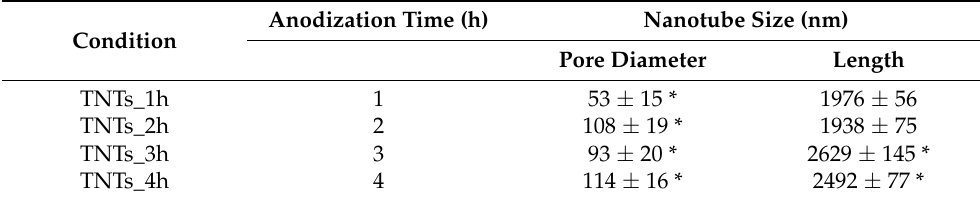
Figure 3. The FESEM micrographs showing the top and side morphological views of the titanium oxide nanotubes fabricated at 1 h ( a , e ), 2 h ( b , f ), 3 h ( c , g ) and 4 h ( d , h ). The morphology images depict the TNTs orientation and the size of the pores. The pores diameter of the nanotube increased with increase in the anodization time while the length decreased. Table 1. Shows the measured inner pore diameters and length of the TNTs at 1, 2, 3 and 4 h anodization time. The measurements were obtained using Image J analysis and the FE-SEM micrographs. (Statical analysis with IBM Spss 22, One-way ANOVA).